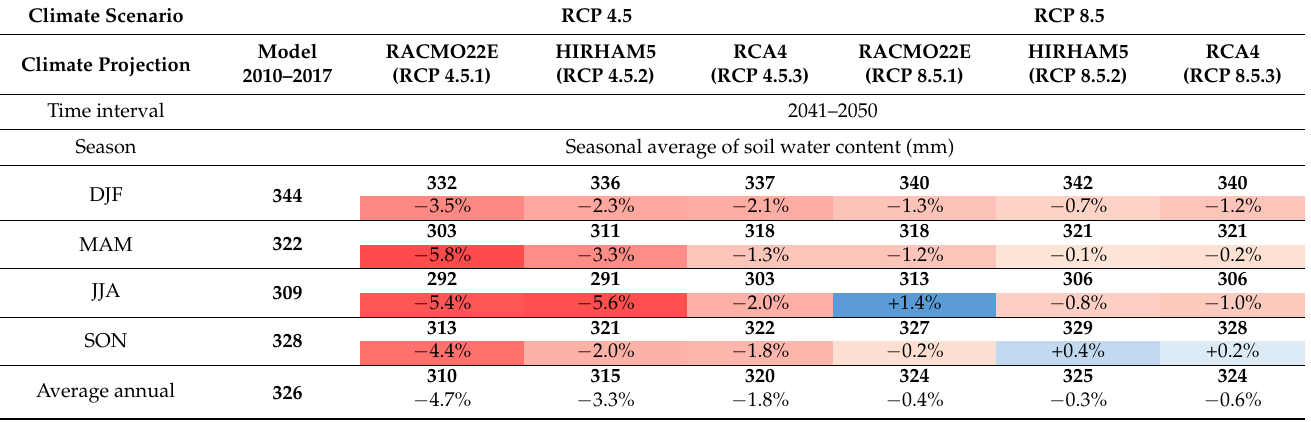
Table 6. Comparison of average soil water content by season between scenario 0 (S-0) and adaptation scenarios 1–5 (AS-1, AS-2, AS-3, AS-4, AS-5) for 2041–2050 in the Bystra catchment for climate projection RCP 4.5.1, RCP 4.5.2, RCP 4.5.3, RCP 8.5.1, RCP 8.5.2, RCP 8.5.3. Bold numbers indicate soil water content, and shaded numbers indicate percentage change (red indicates % decrease in content and blue indicates % increase in content). Dark red and dark blue shading indicates large changes, while light red and light blue shading indicates small changes (own study).